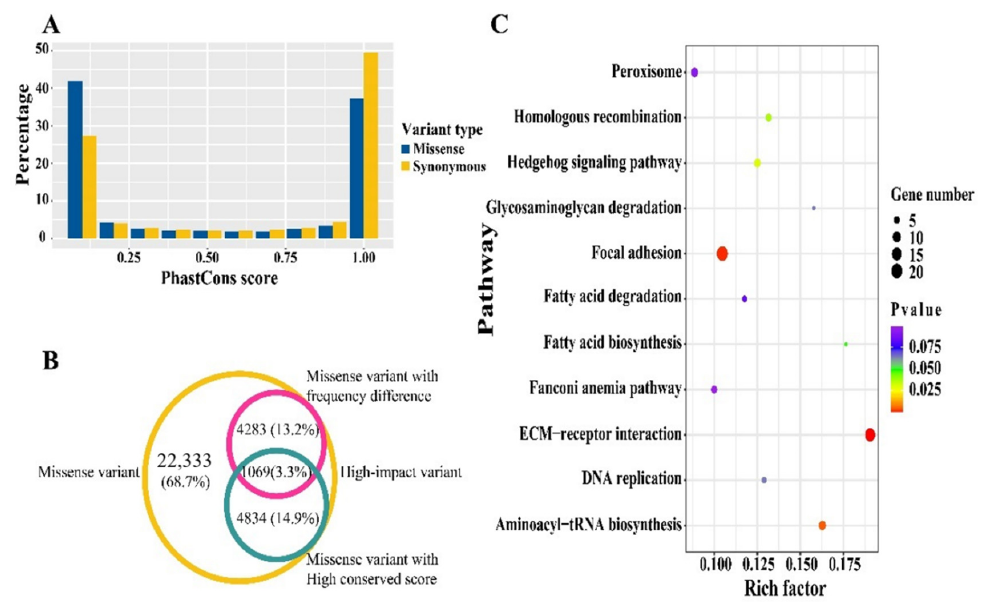
Figure 3. Conservation analysis, annotation and enrichment analysis for high-impact variants. ( A ) Ratio of variants with various conservation score. ( B ) Overlapping of different types of missense variants, the missense variants with frequency difference and high conserved score were defined as the high-impact SNPs. ( C ) KEGG pathways enriched by genes harboring high-impact SNPs.